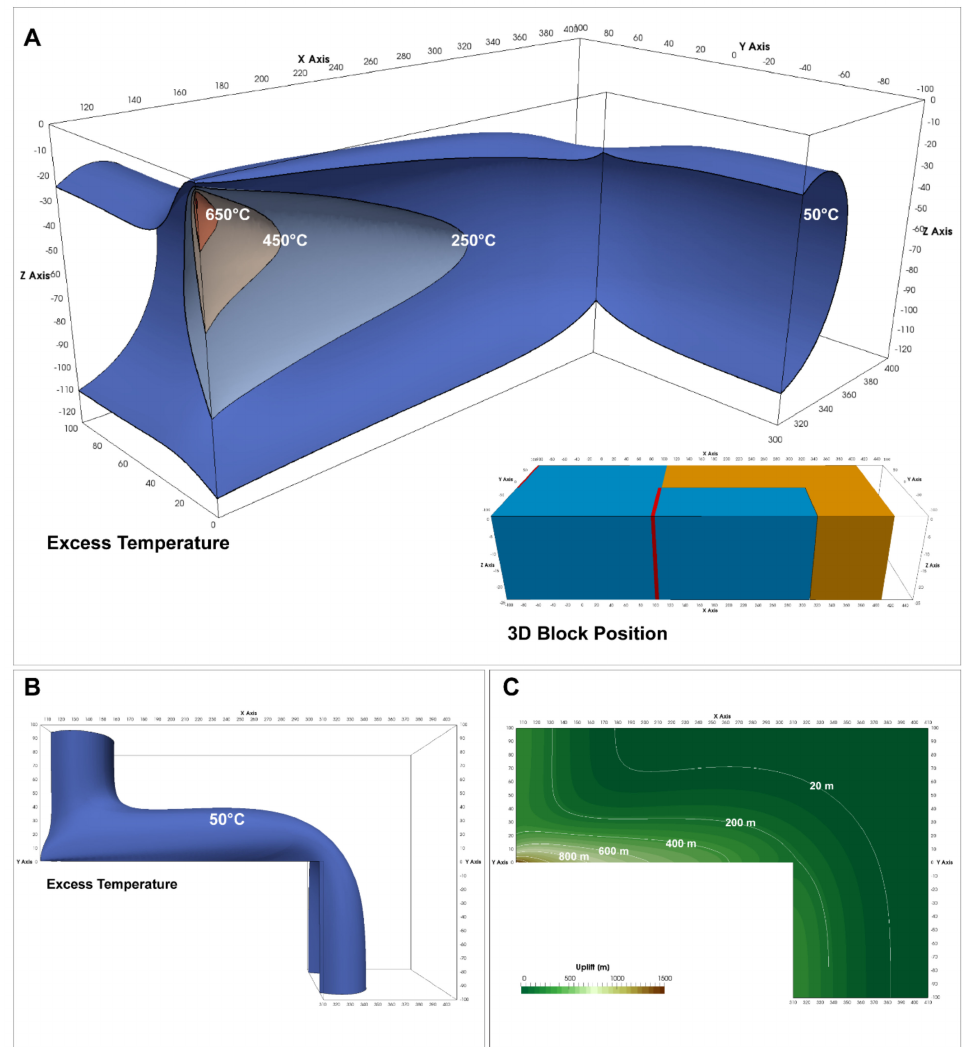
Figure 13. Thermal state of the continental block at the end of Stage A (20.5 Myr). ( A ) Side view of excess temperature contour surfaces within the continental lithosphere with a 200 ◦ C stepping. Inset shows the position of the 3D marker block. ( B ) Map view of the 50 ◦ C excess temperature contour surface. ( C ) Uplift experienced by the continental lithosphere at the end of Stage